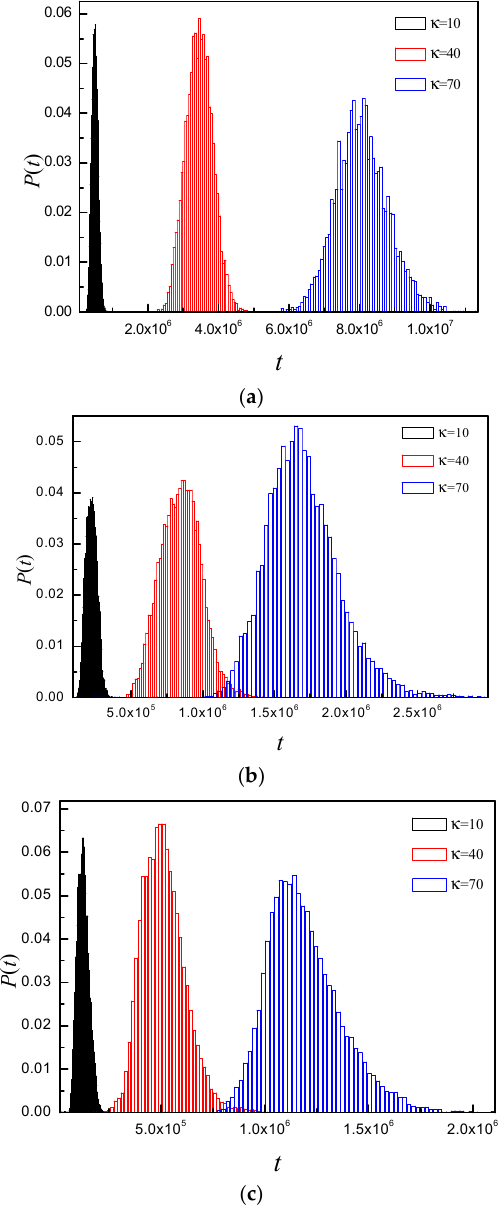
Figure 8. The probability distribution of the translocation time for different κ at: ( a ) E = 1.5; ( b ) E = 5; and ( c ) E = 15. Here, R = 5, N = 150.